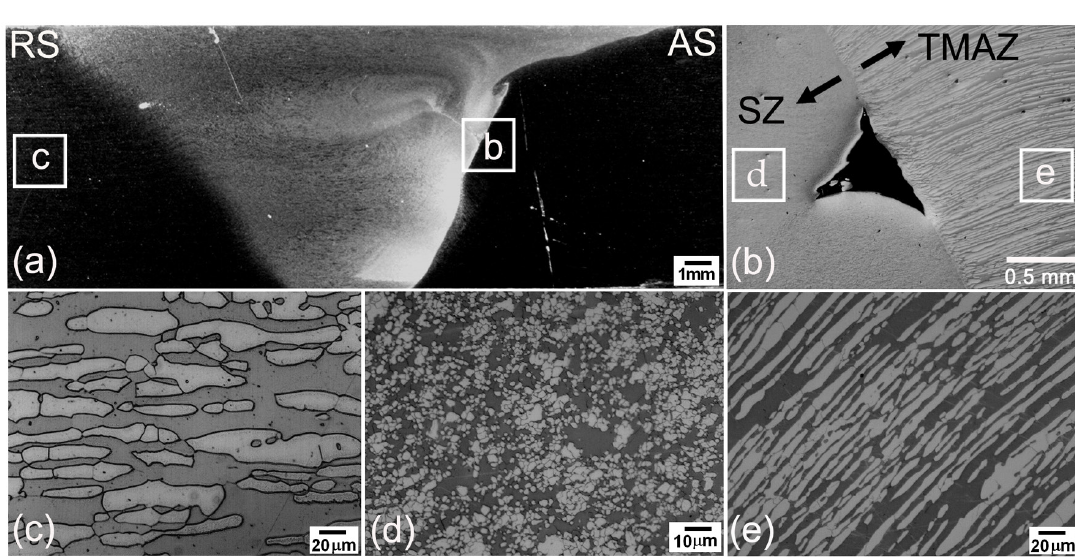
Fig. 3. Optical microscopy cross section of a friction stir welded UNS S32760 SDSS joint: (a) macrograph of welded joint, (b) SZ/TMAZ-AS interface showing a fill defect, (c) BM, (d) SZ, and (e) TMAZ on advancing side.